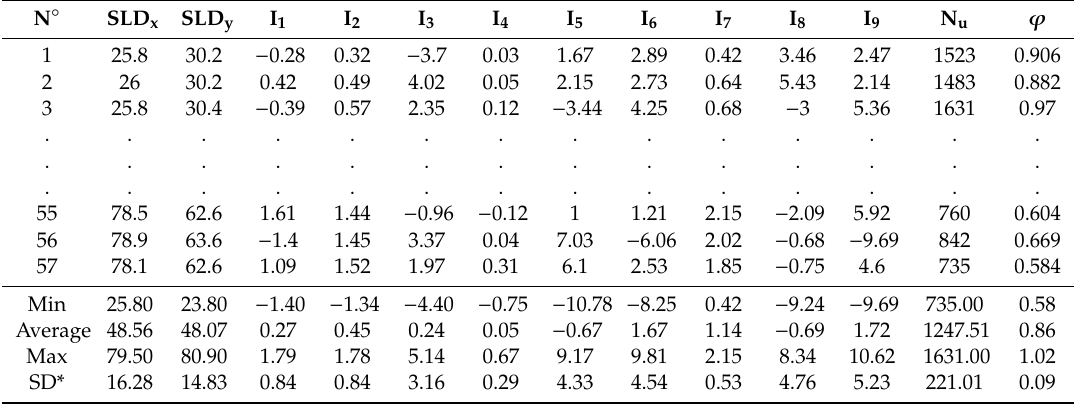
Table 1. Inputs and output of the present